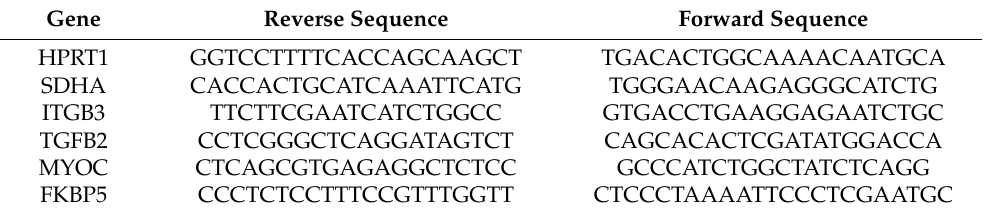
Table 1. Primers used for RT-qPCR. All sequences are given in the 5 (cid:48) to 3 (cid:48) direction. Gene Reverse Sequence Forward Sequence